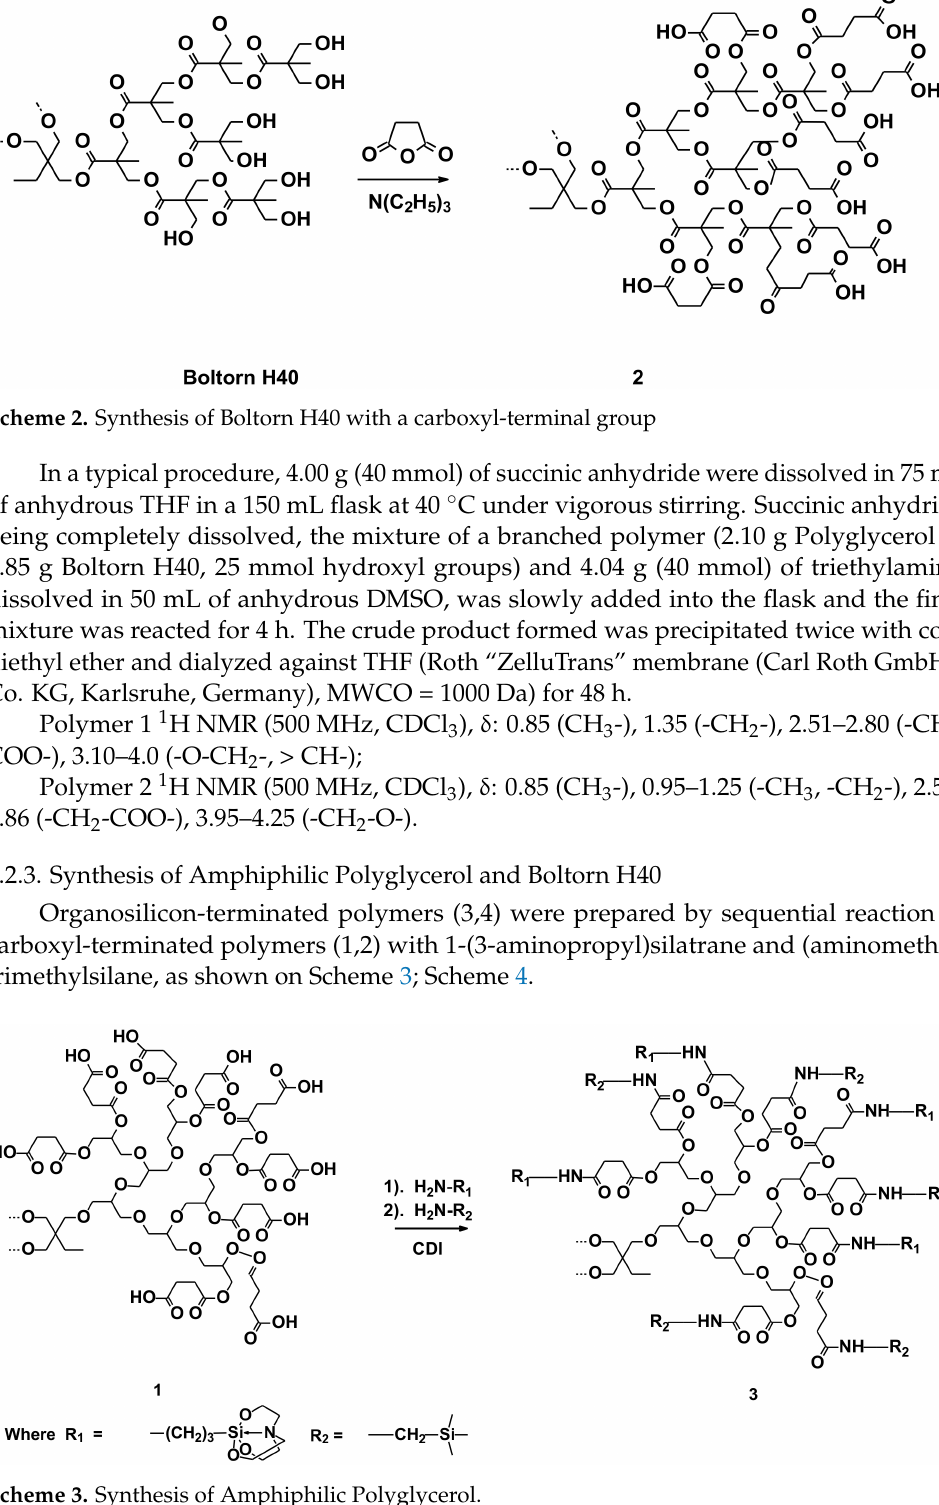
Scheme 3. Synthesis of Amphiphilic